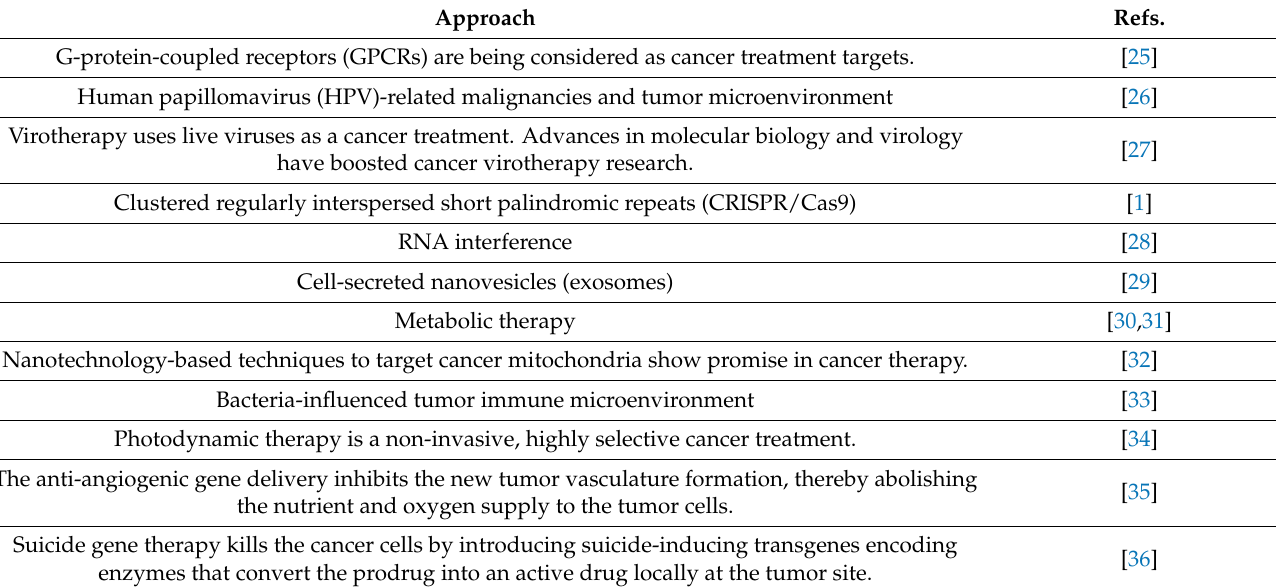
Table 1. Cont. Approach